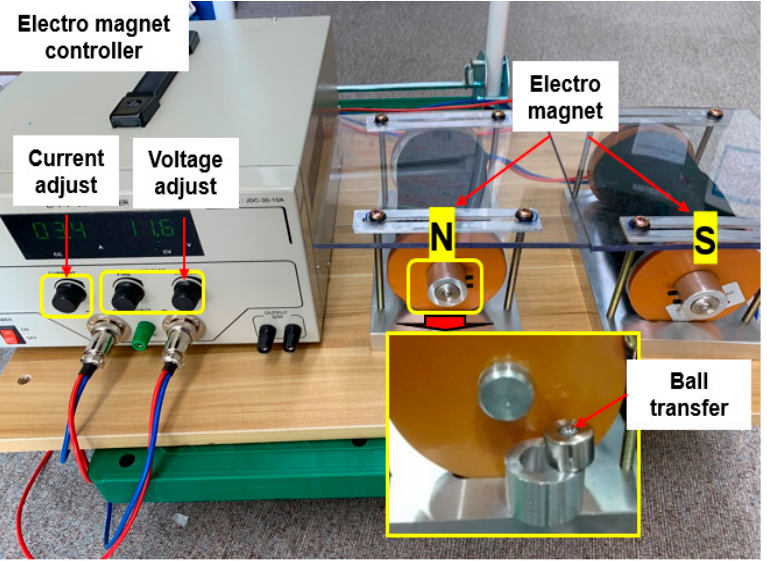
Figure 1. Modeling manual electromagnet with ball roller.